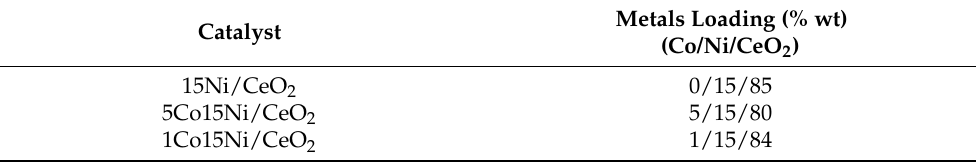
Table 6. Studied